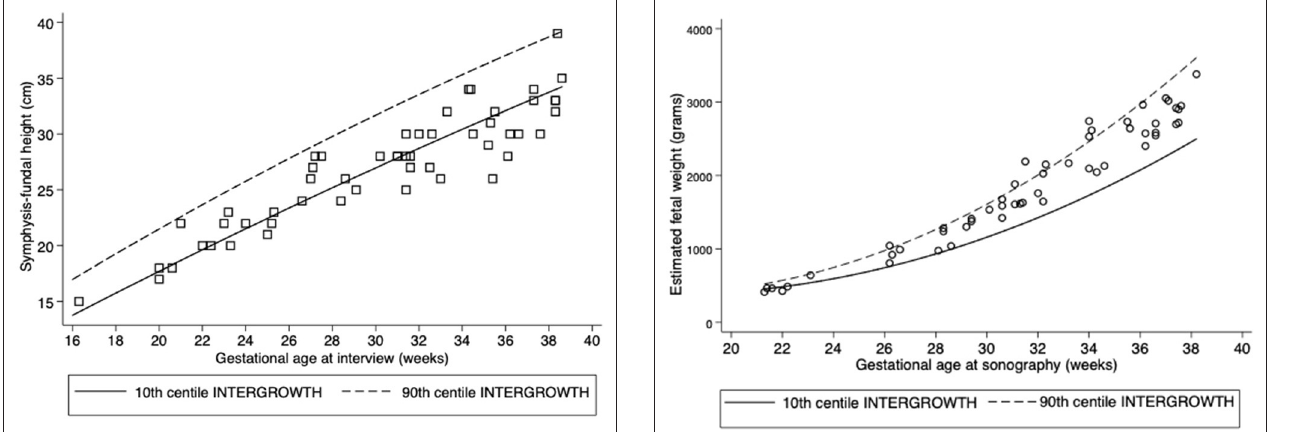
FIGURE 2 | Scatter plots of sonography-estimated fetal weight (grams). Lines correspond to the 10 and 90th centiles according to INTERGROWTH